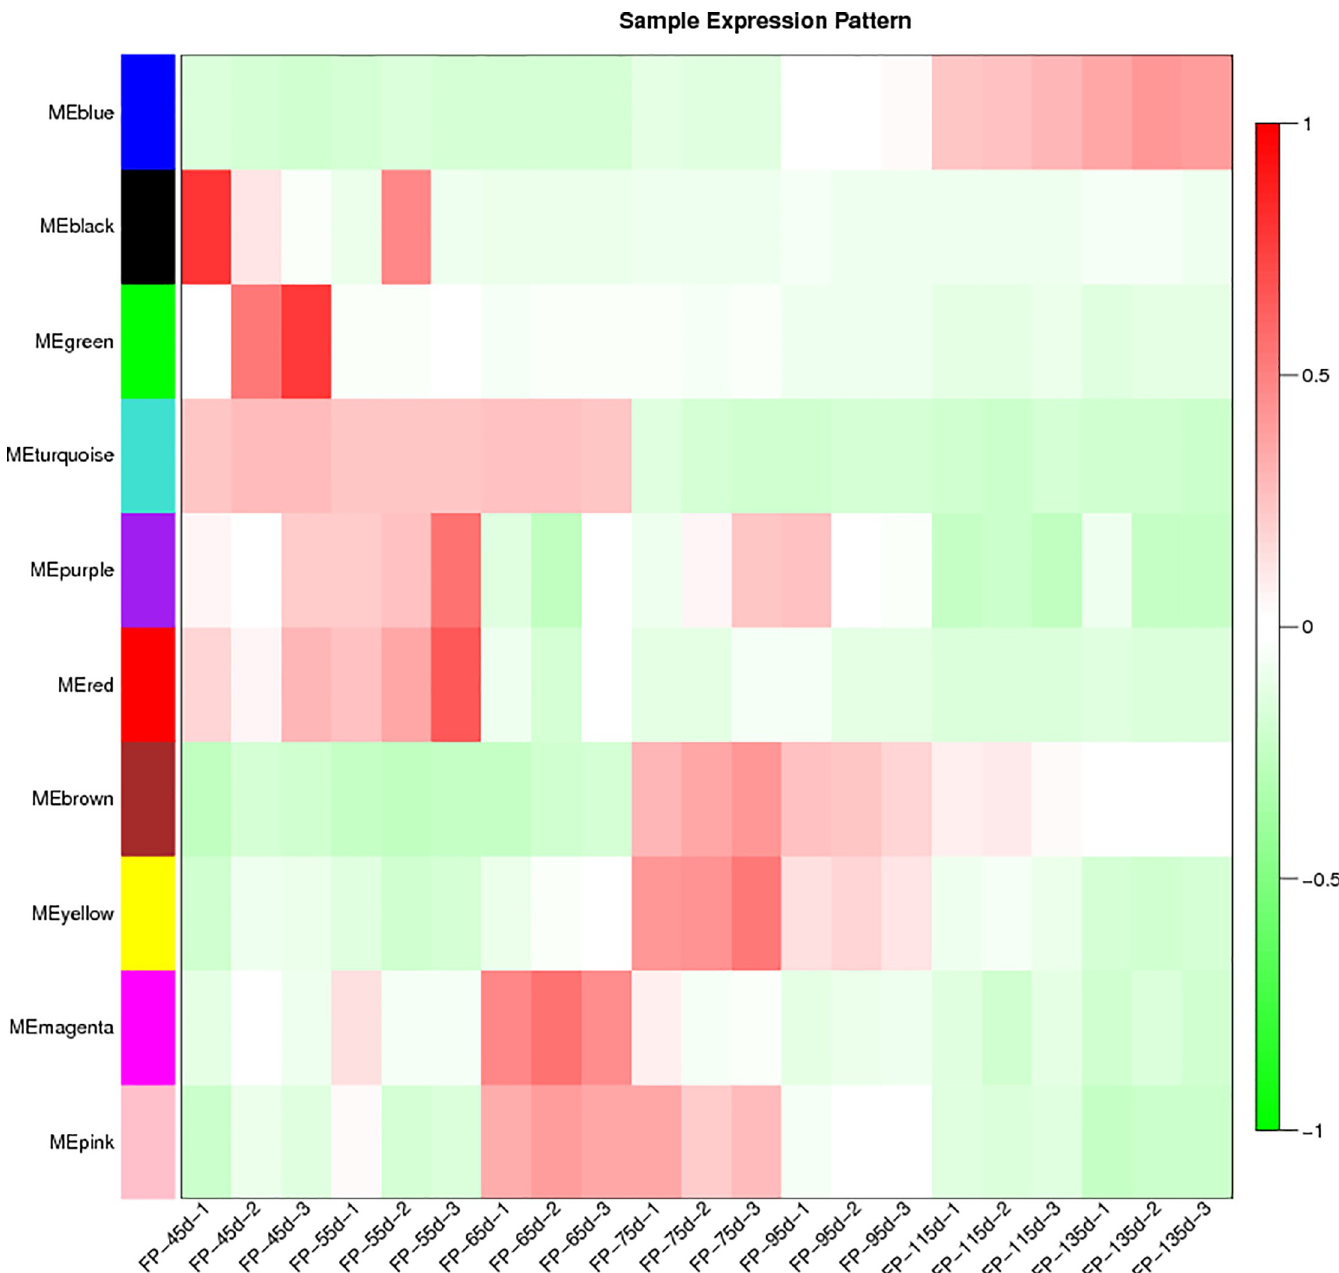
Fig 4. Heat map of sample expression pattern. Abscissa represents the sample and ordinate represents the module, based on module eigenvalues. Red: High expression; green: Low expression.